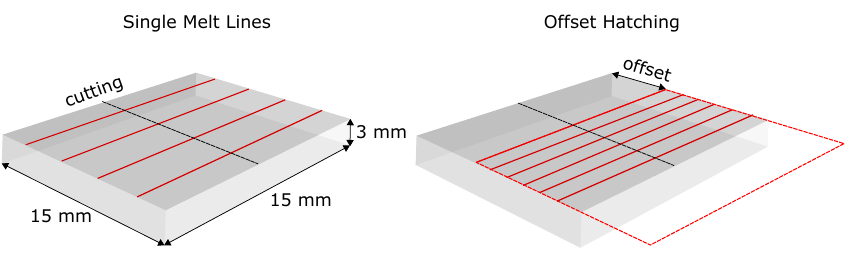
Figure 1. Schematic setup of the single-melt line and offset hatching remelting experiments. The offset was about